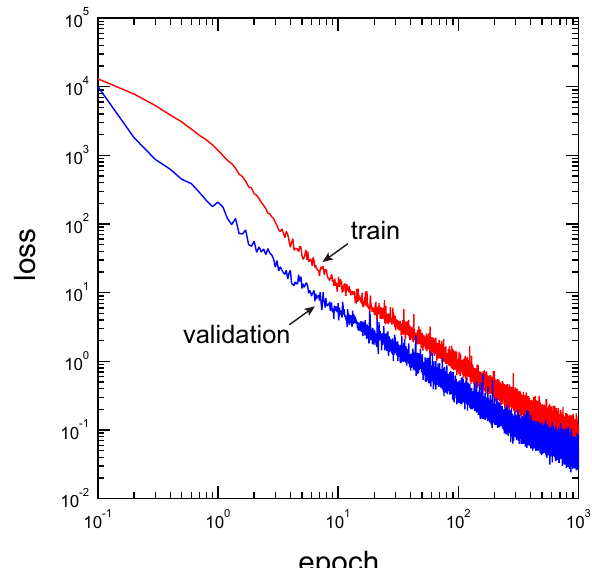
Figure 3. Training and validation losses per mini-batch as functions of the number of epochs (red: training loss, blue: validation